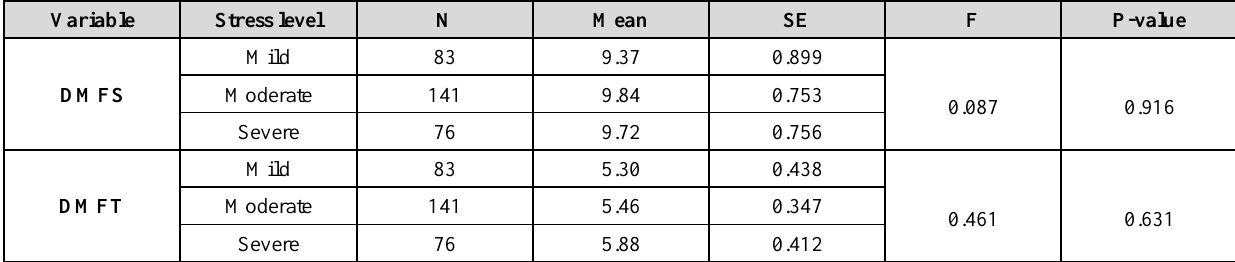
Table 3: Salivary physicochemical characteristics among dental students of mild and severe dental environment stress